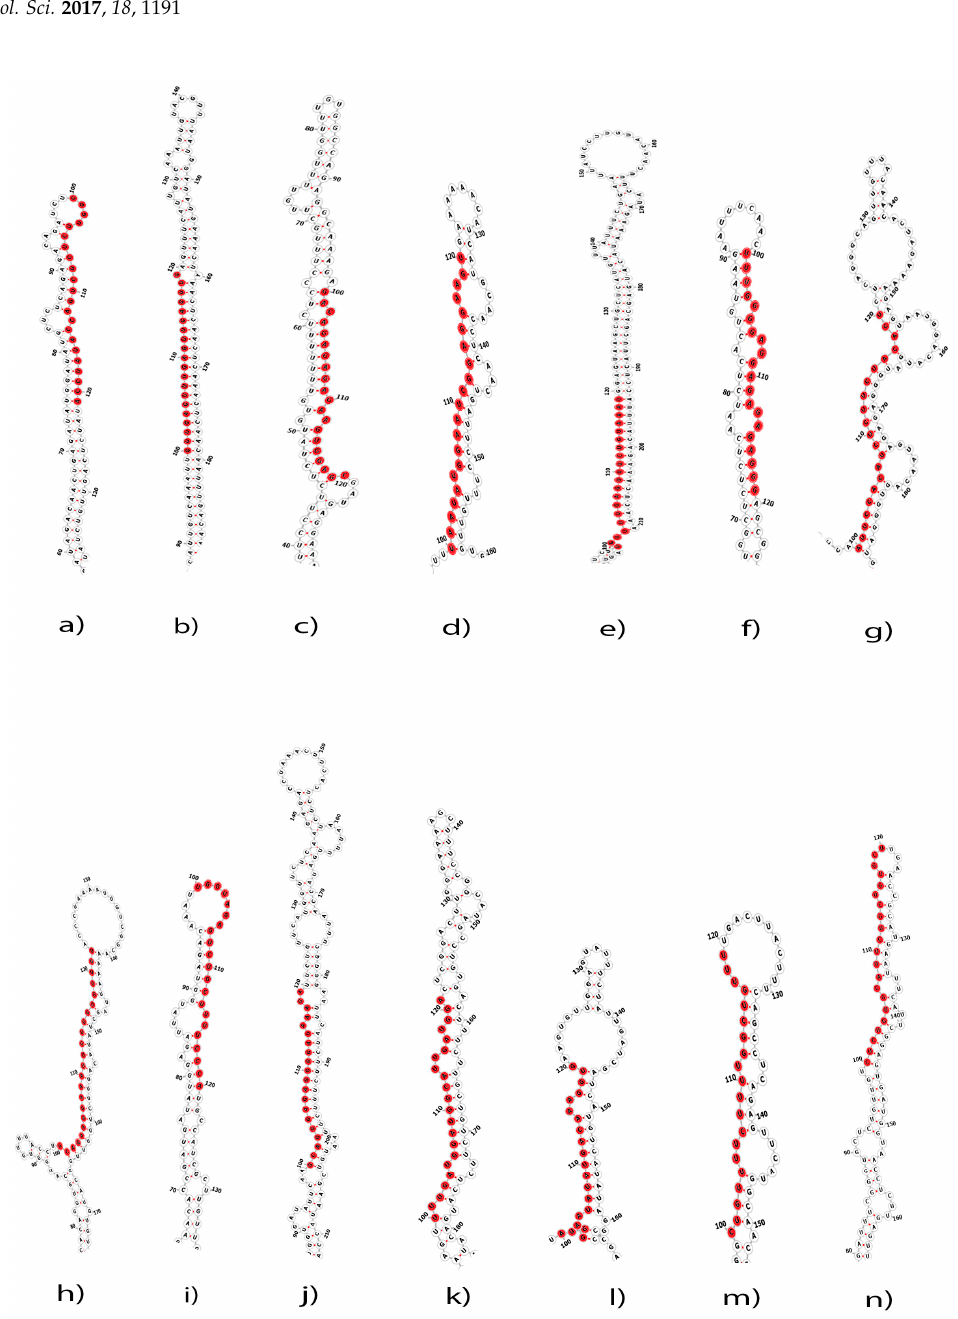
Figure 1. Predicted hairpin stem loop secondary structures of 14 putative miRNAs identified in